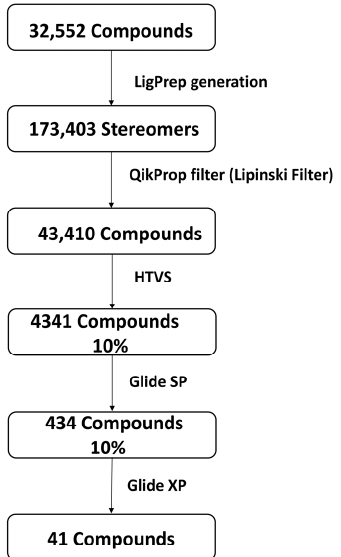
Figure 1. Phases of compound screening along with compound (ligands) preparation using Schrödinger Release 2021–3 packages.